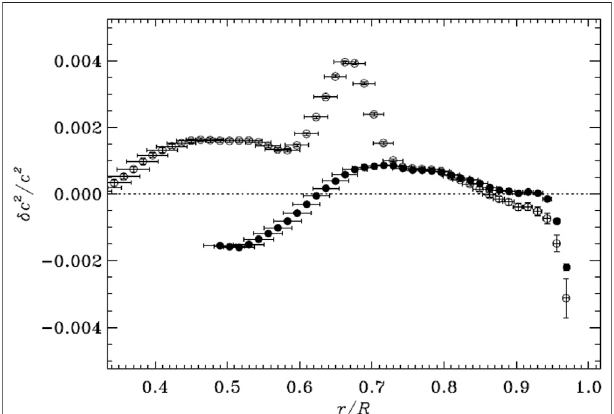
FIGURE 5 | Relative differences in squared sound speed between the Sun and the reference model from the sound-speed inversion (Zhang et al., 2012). The open and fi lled circles are, respectively, for the standard model S (Christensen-Dalsgaard et al., 1996) and our non-local model of the Sun (Xiong and Deng, 2001) as the reference